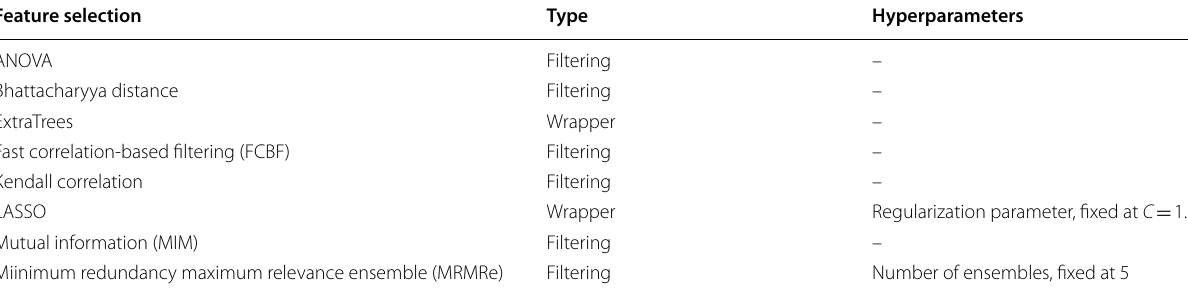
Table 2 Overview of all feature selection methods used